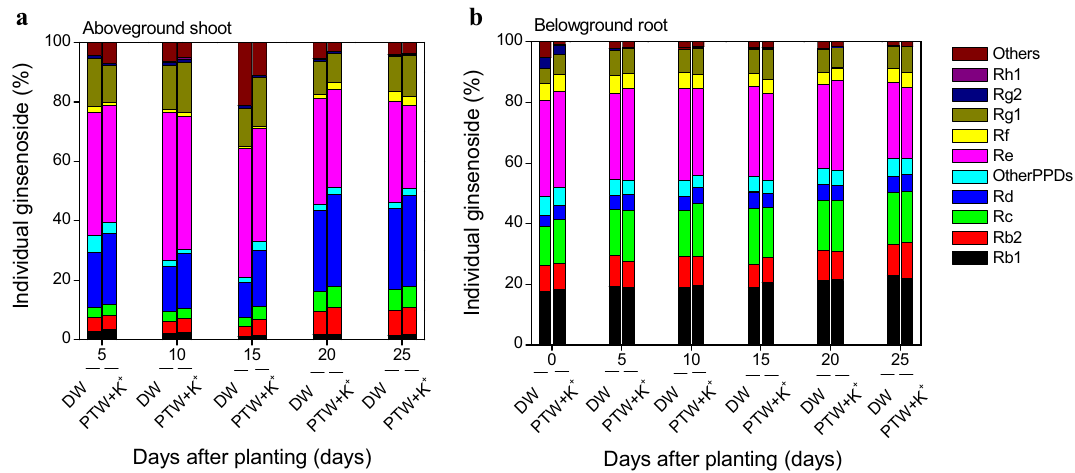
Figure 4. The percentages of individual ginsenosides in the aboveground shoot ( a ) and belowground root ( b ) of Panax ginseng , each sprayed with deionized water (DW) and plasma-treated water (PTW) containing potassium ions (K + ) for 25